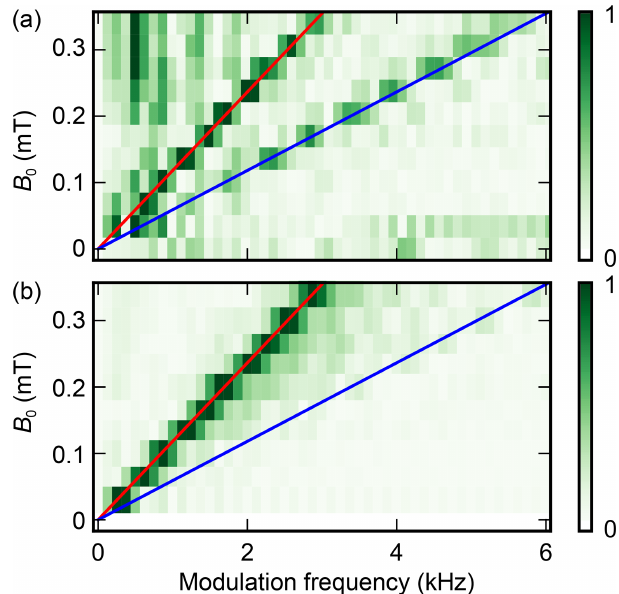
Figure 10. Amplitude of the Fourier transform of the experimen- tal (a) and theoretical (b) two-pulse Bi : Si donor ESEEM